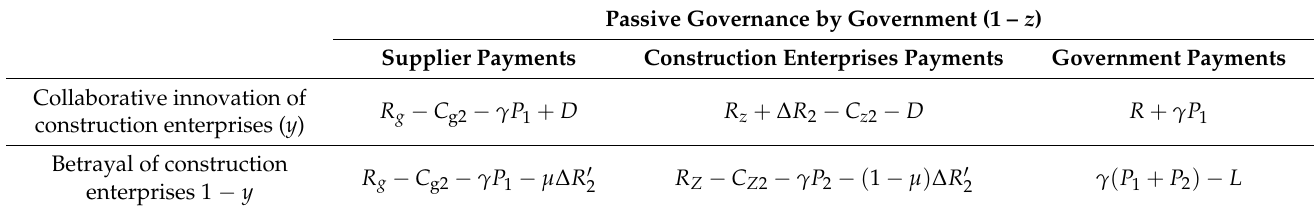
Table 4. The tripartite game payment matrix of supplier betrayal (1 − x ).